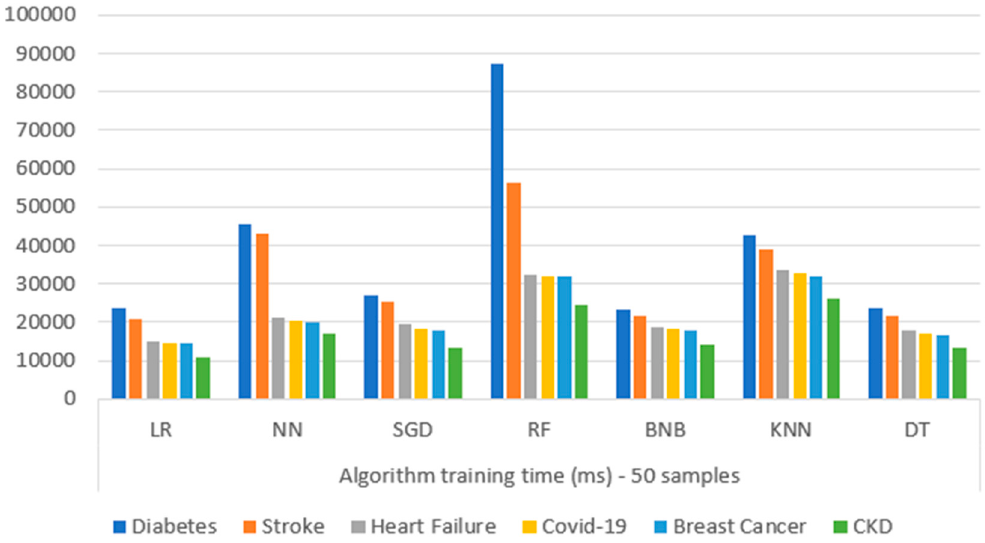
Figure 33. Training performance comparison for each algorithm per dataset.